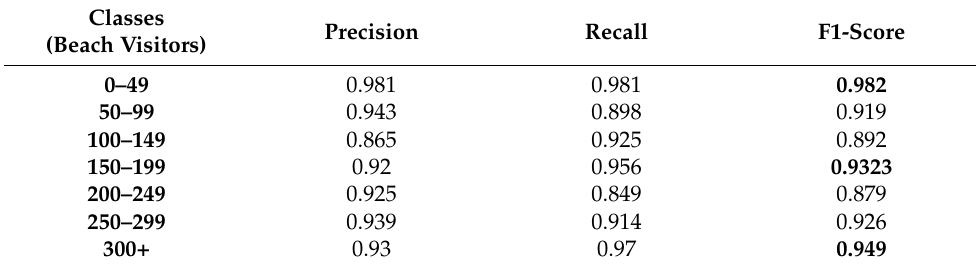
Table 6. Per-class precision, recall, and F1-scores for the time period 2016–2018.